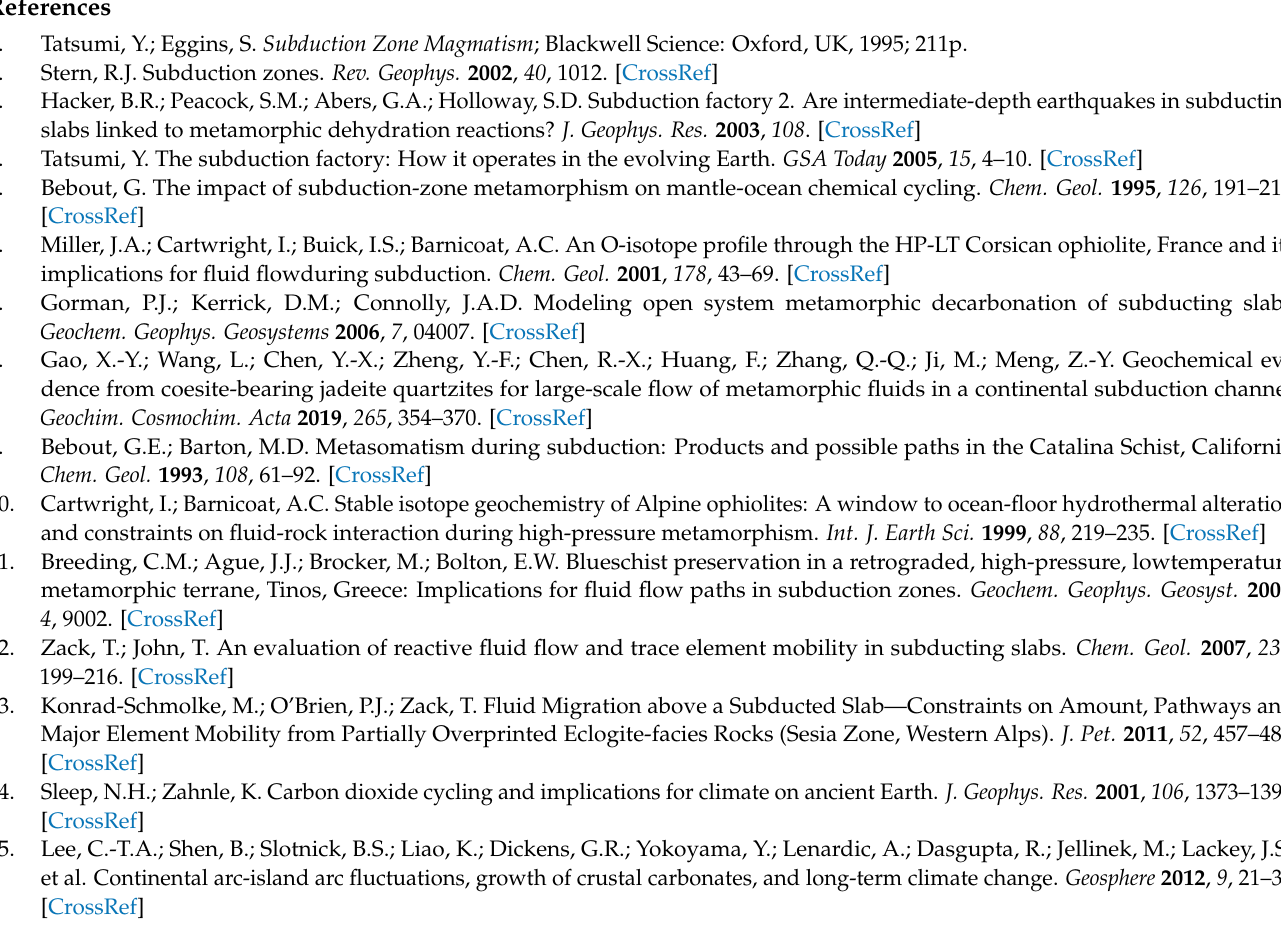
Table S1: EMP analyses for minerals in the chlorite schist; Table S2: SHRIMP oxygen isotope analyses for minerals from the BIF and chlorite schist; Table S3: Bulk rock composition of the chlorite